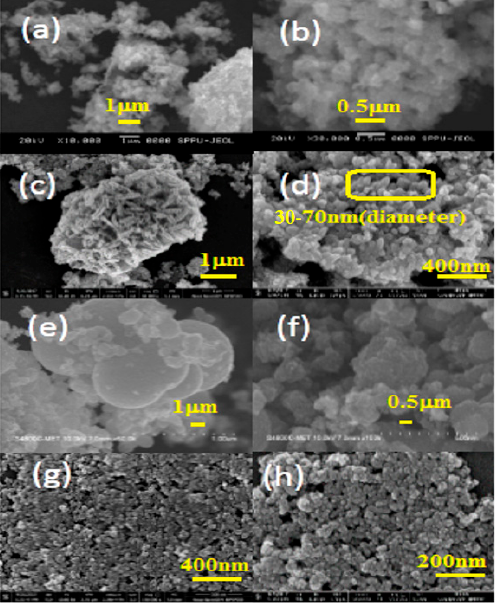
Figure 2. Field emission scanning electron microscopy (FE-SEM): ( a , b ) Pristine ZnO, ( c , d ) FL–ZnO, ( e , f ) Pristine TiO 2 and ( g , h ) FL–TiO 2 .